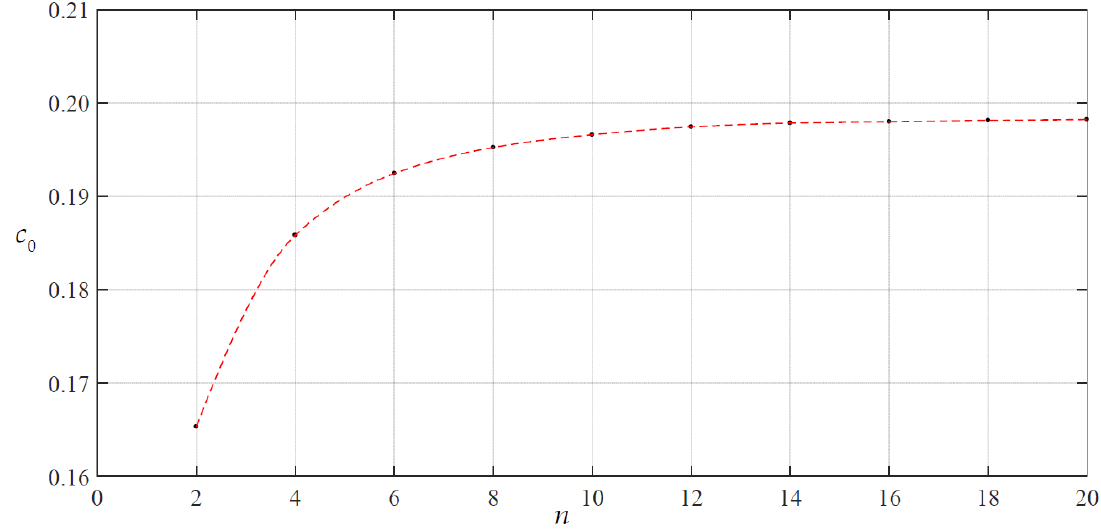
Figure 3. Variation of c 0 with n when H = 300 mm.